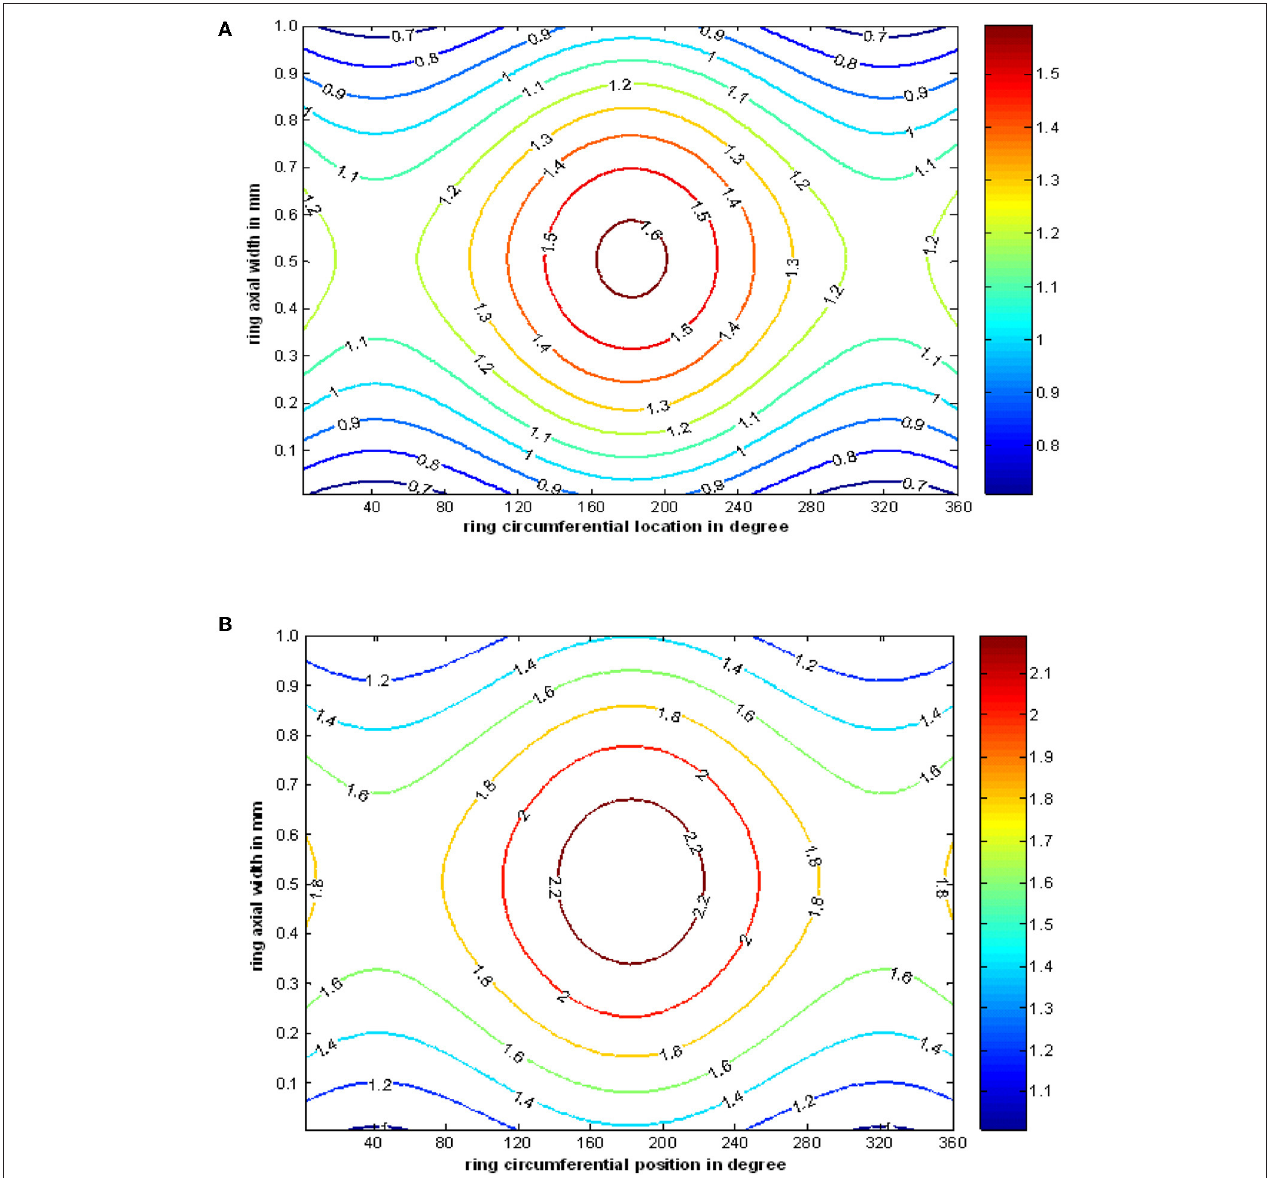
FIGURE 8 | Contour of asperity contact pressure in MPa at higher gas loading, for (A) compression stroke ( θ c and (B) power stroke ( θ c